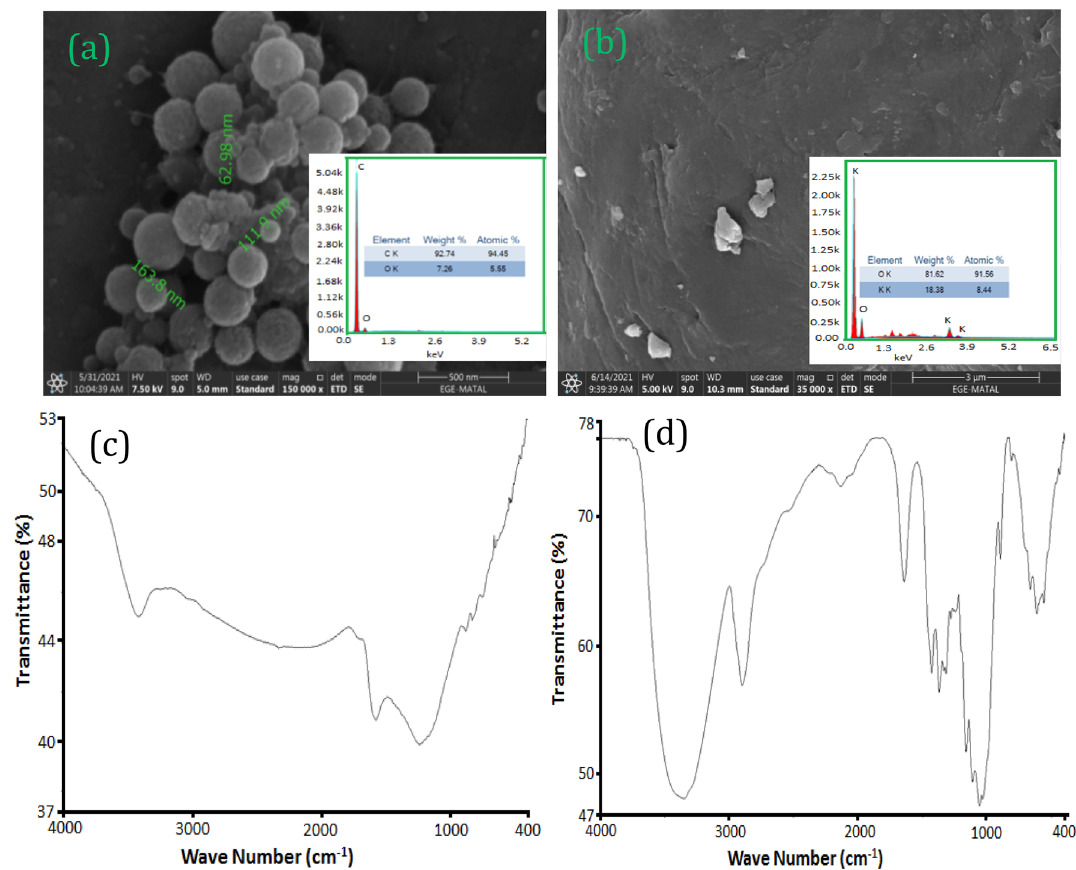
Figure 2. ( a ) SEM of CNPs, ( b ) SEM of TLE, ( c ) FTIR of CNPs, ( d ) FTIR of TLE.